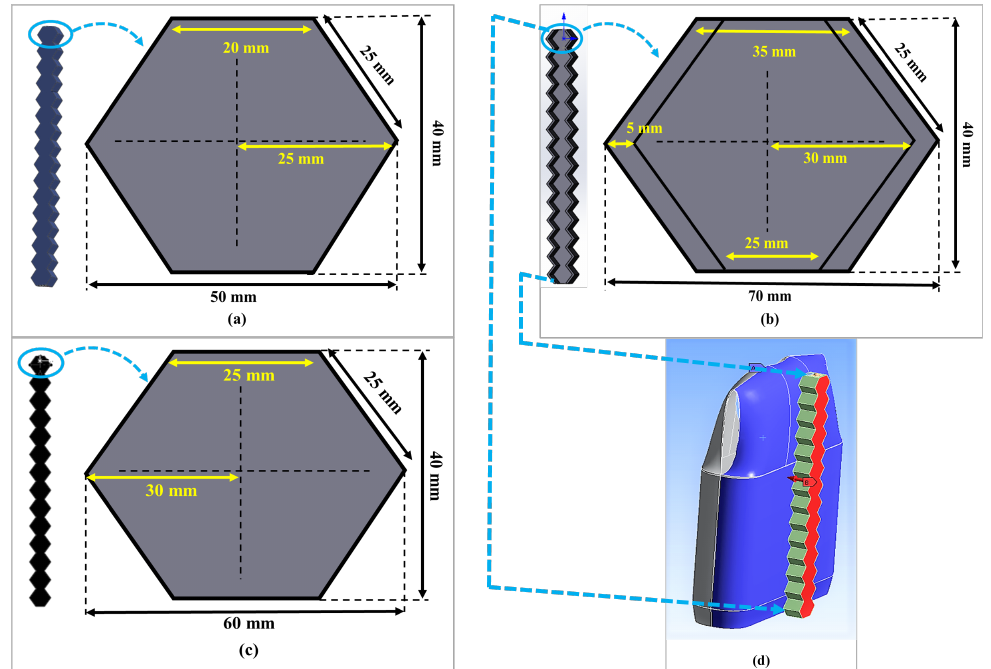
Figure 4. Design of the posture corrector ( a ) skeleton blocks, ( b ) skeleton frame, ( c ) skeleton frame cap, and ( d ) an image of designed posture corrector placed in a